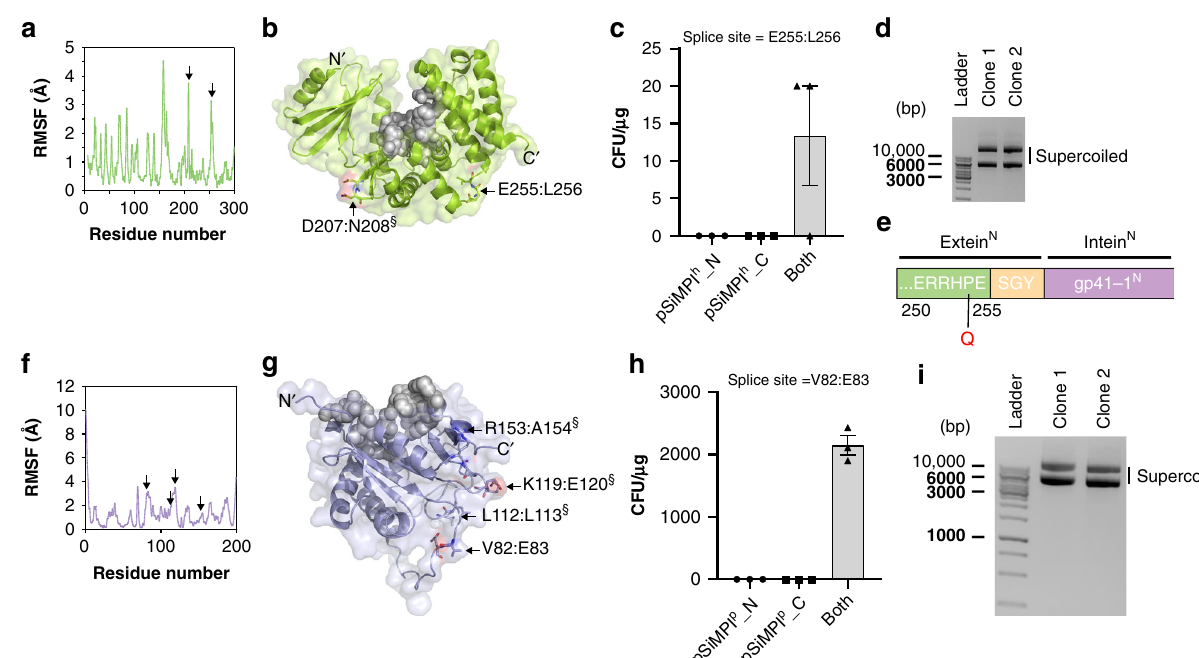
Fig. 5 SiMPl based on hygromycin and puromycin. a , f Root mean square fl uctuation (RMSF) of C α atoms in hygromycin B phosphotransferase (PDB ID: 3w0s) ( a ) and the model structure of puromycin acetyltransferase ( f ) obtained from protein structure fl uctuation simulations via the CABS- fl ex 2.0 web- server 20 . Flexible regions, within which splice sites were selected, are indicated by black arrows. b Crystal structure of hygromycin B phosphotransferase (PDB ID: 3w0s). g Tertiary structure model of puromycin acetyltransferase. ( b ) and ( g ) Residues that are part of the active site are represented as gray spheres. Splice sites are represented as sticks and are pointed at by black arrows. Section sign (§), splice site that did not support bacterial growth. c , h Bar graph showing the transformation ef fi ciency in E. coli TOP10 cells of the indicated plasmids. Values represent mean (± standard error of the mean) of three independent experiments. d , i Ethidium bromide-stained agarose gel showing plasmid DNA isolated from two clones obtained after transformation with the SiMPl plasmids based on hygromycin ( d ) and puromycin ( i ). e Schematic representation of the N-terminal intein construct in pSiMP h _N based on hygromycin. The last few residues of the N-terminal fragment of hygromycin B phosphotransferase are shown. The residue that was mutated in vivo by the bacteria is highlighted (white, WT residue; red, acquired residue). Source data are provided as a Source Data fi